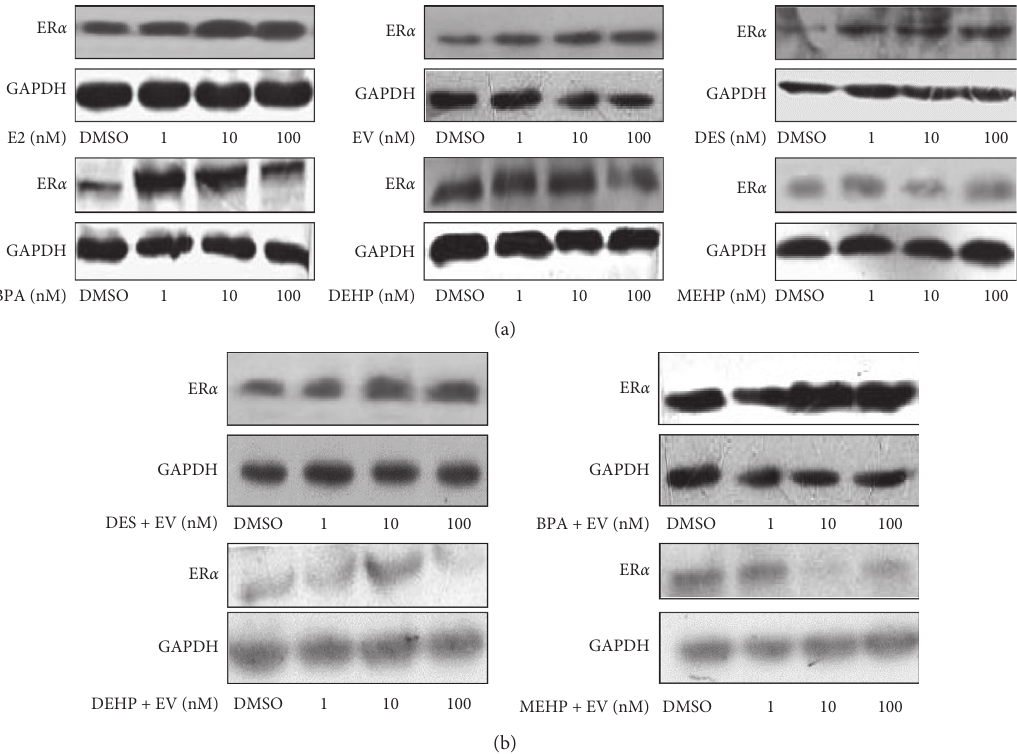
Figure 7: Effects of single EDCs (1–100nM) on the expression of ER α by western blot analysis (a); joint effects of binary mixtures of EV and the other four EDCs (1–100 nM) on the expression of ER α by western blot analysis expression was analyzed by western blot. As shown in Figure 7, E2, EV, DES, and BPA upregulated the ER α protein expression, and the binary mixtures of EV and DES or BPA also upregulated ER α protein expression at the exposure concentrations of 1, 10, and 100 nM.